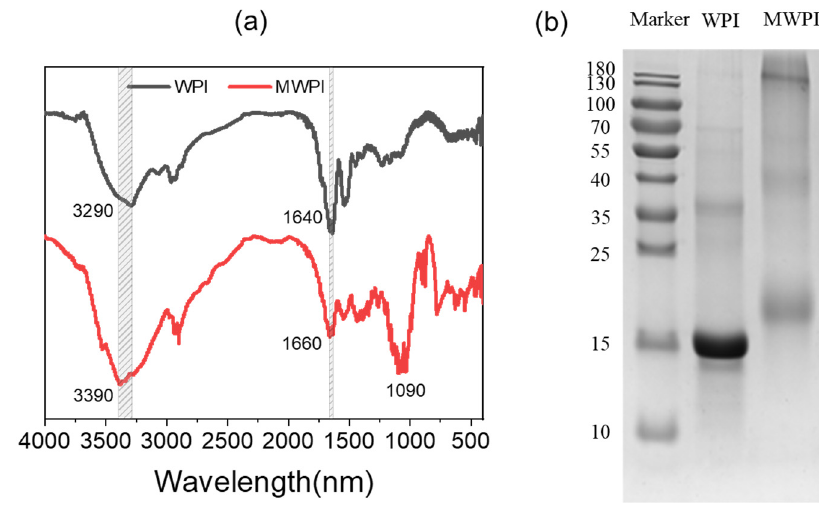
Figure 1. FTIR spectra ( a ) and SDS-PAGE ( b ) of WPI and